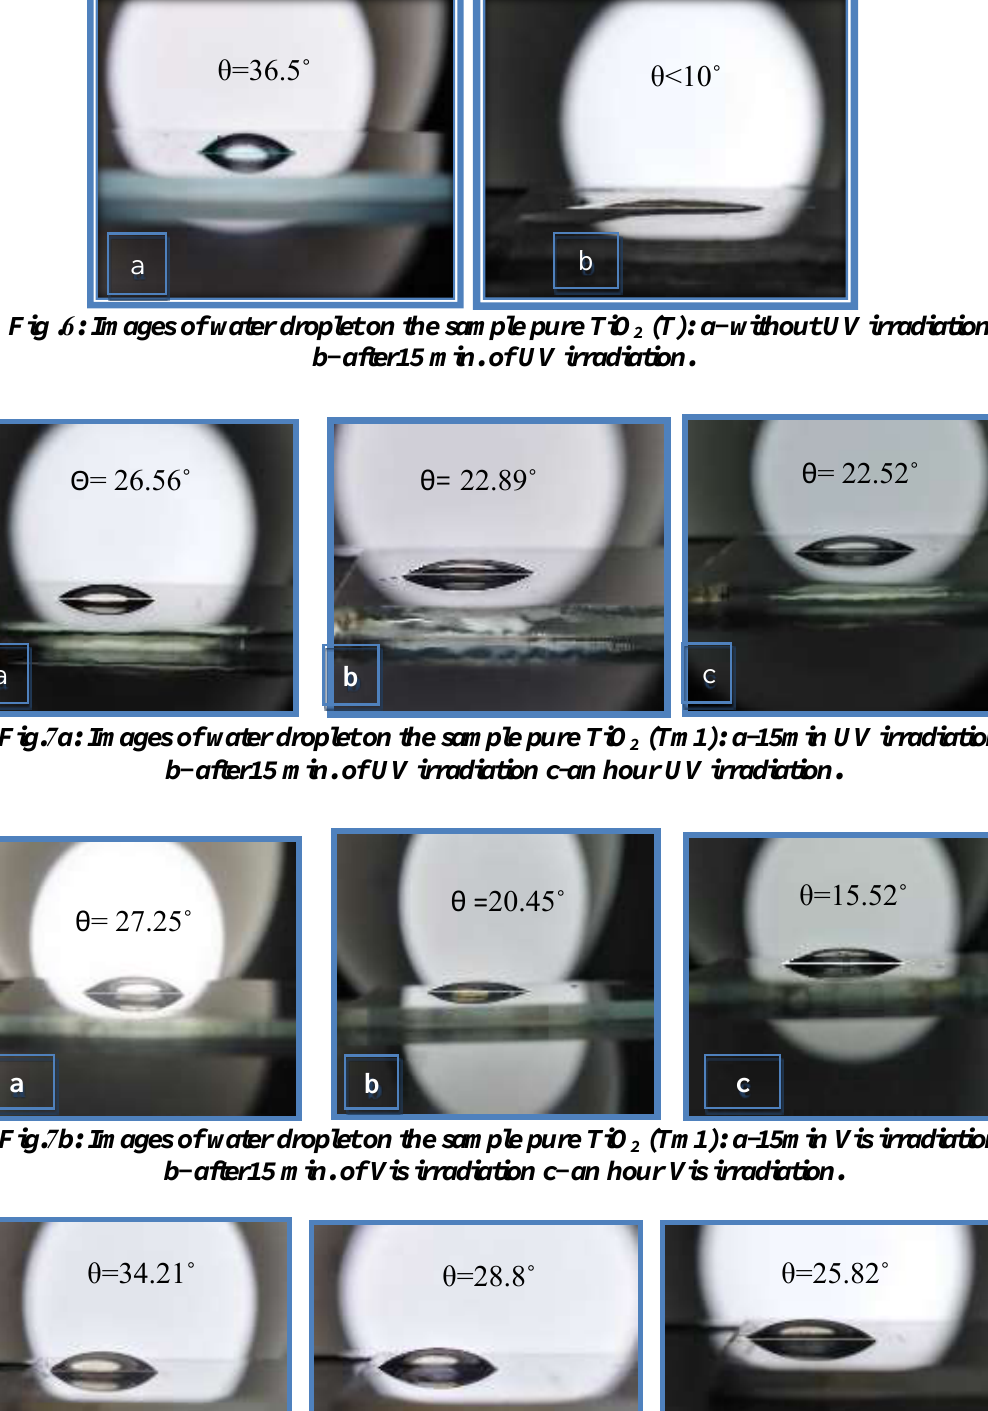
(Tm2): a-15min UV irradiation, 2